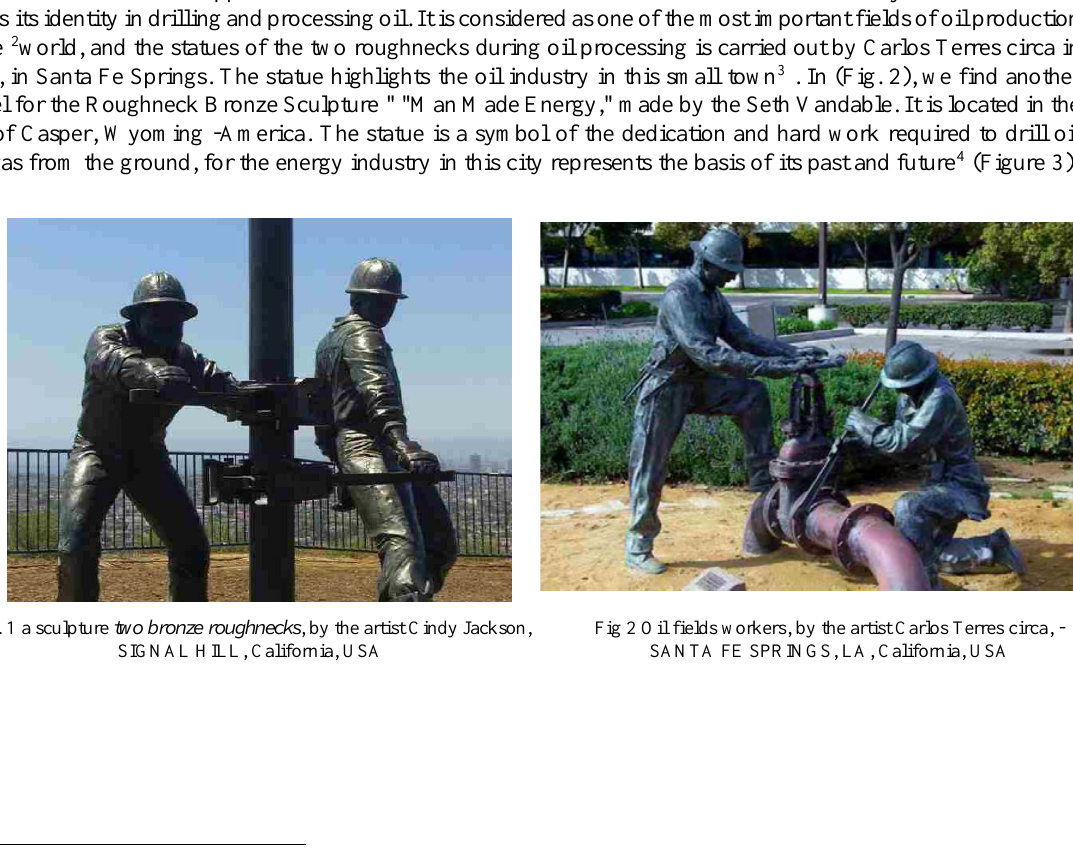
Fig 2 Oil fields workers, by the artist Carlos Terres circa, - SANTA FE SPRINGS, LA, California,